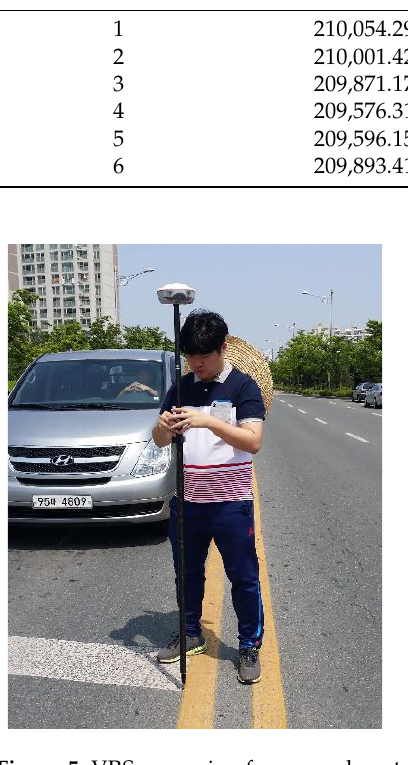
Figure 5. VRS surveying for ground control point (No.1). As for the video taken by the UAV, as shown in Figure 6, 70 red, green, blue, and near-infrared (NIR) bands pictures were taken with a Canon s110 NIR camera and 3131 thermal-infrared bands pictures used a thermoMAP camera. The image was merged using Pix4D Mapper S/W, and the ‘GCP Manger’ function was used to match the surveying coordinates of the ground control point to increase the positional accuracy of the UAV image. Through this process, orthomosaic images of red, green, blue, near-infrared (Nir), and thermal-infrared bands required for vegetation index analysis were constructed (Figure 7).